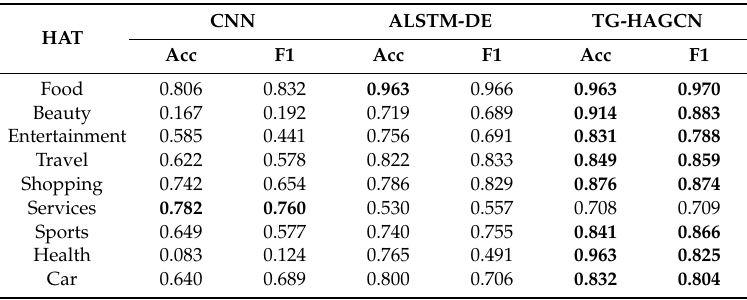
Table 3. Comparison with baseline models (where “Acc” means accuracy, “F1” means F1-score, “Mac” and “Mic” are the prefixes of “Acc” and “F1” to indicate macro / micro-average accuracy and F1-score). For each row, the best Acc and F1 are indicated in